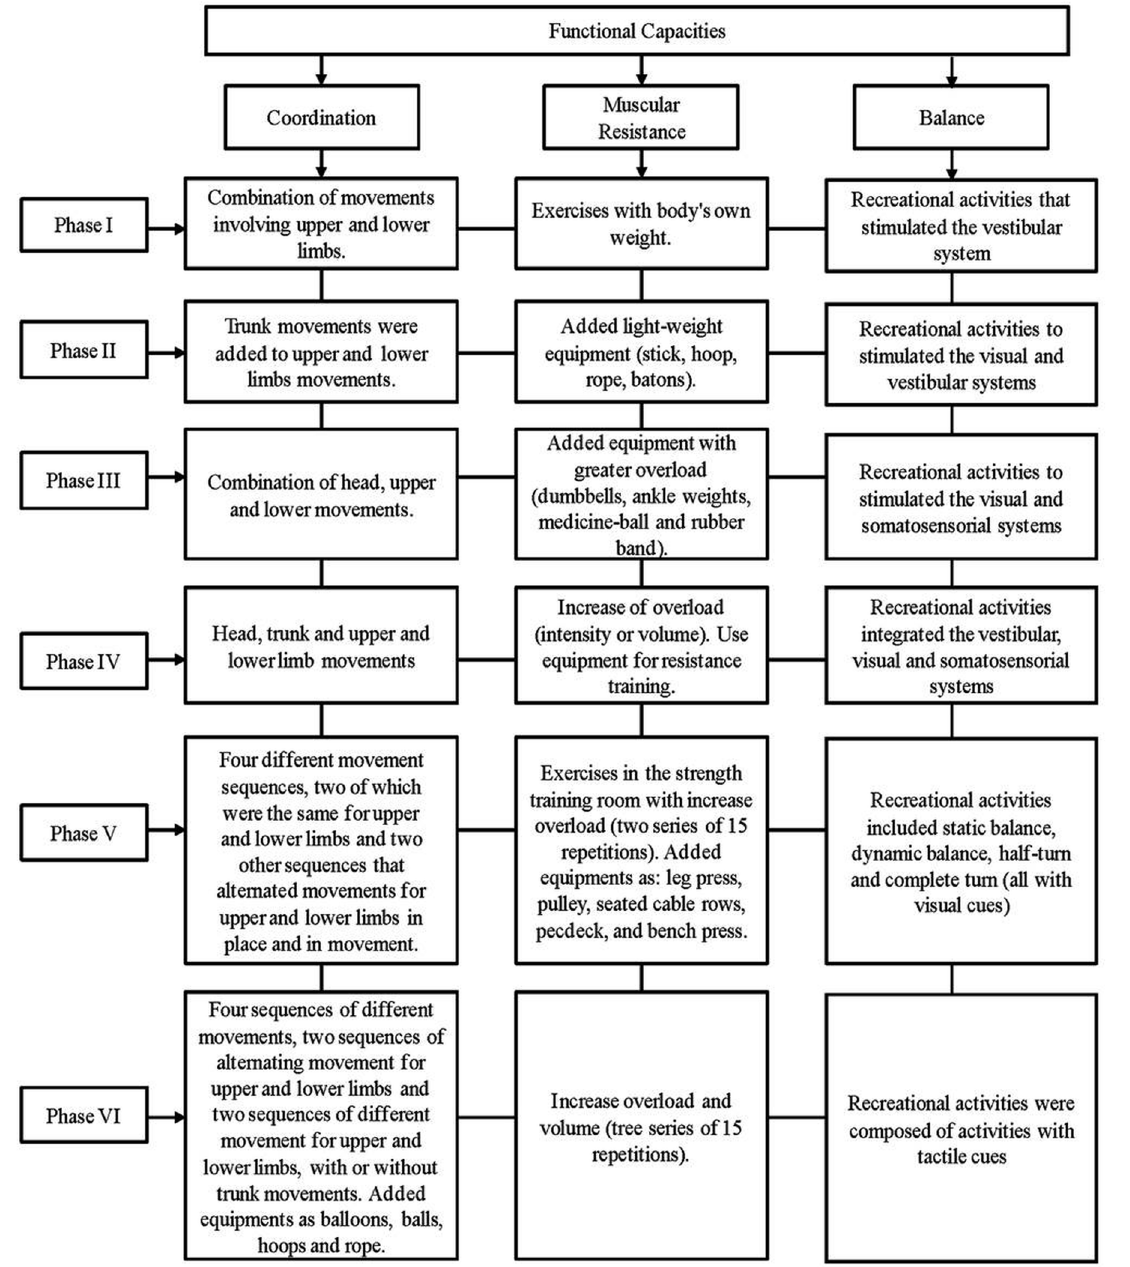
Figure 1. Phases of 6 months of the multimodal exercise protocol with progressive increments on volume, intensity and